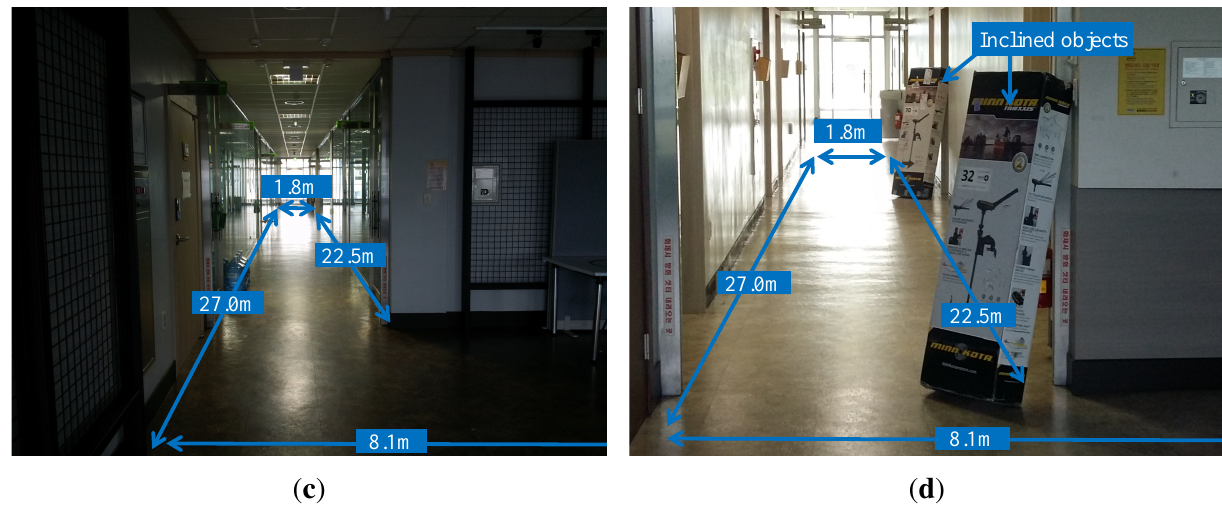
Figure 10. Experimental environment. Dataset 1 is a long corridor. Datasets 2, 3 and 4 are L-shaped, and some parts of the wall in Dataset 3 are glasses. Datasets 2 and 4 are the same place. However, two inclined objects are placed in Dataset 4. ( a ) Dataset 1; ( b ) Dataset 2; ( c ) Dataset 3; ( d ) Dataset 4.